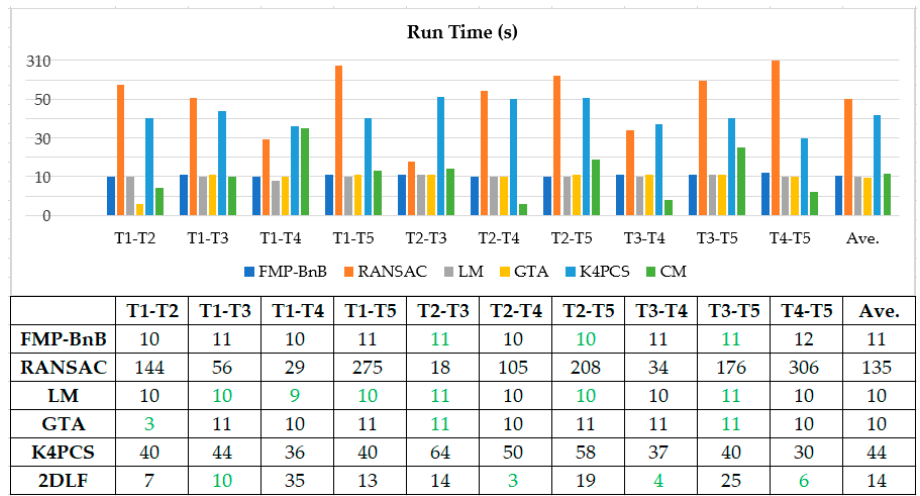
Figure 11. Run time to register point cloud pairs from dataset SR (the most time-efficient method for each pair is colored in green).